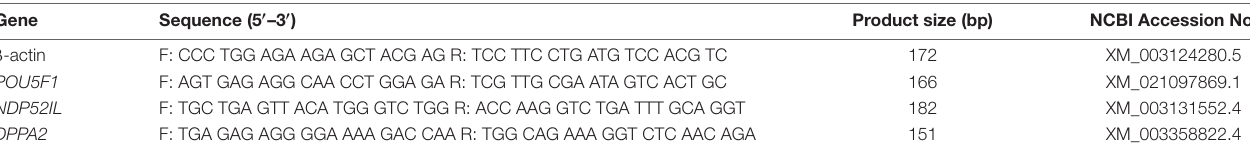
TABLE 1 | Specific primers used for quantitative reverse transcription polymerase chain reaction for the gene expression analysis.